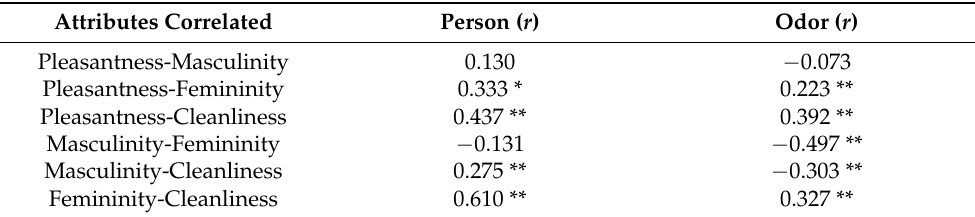
Table 4. Relationships between attributes both within the context of the hypothetical person and the direct ratings of the averaged